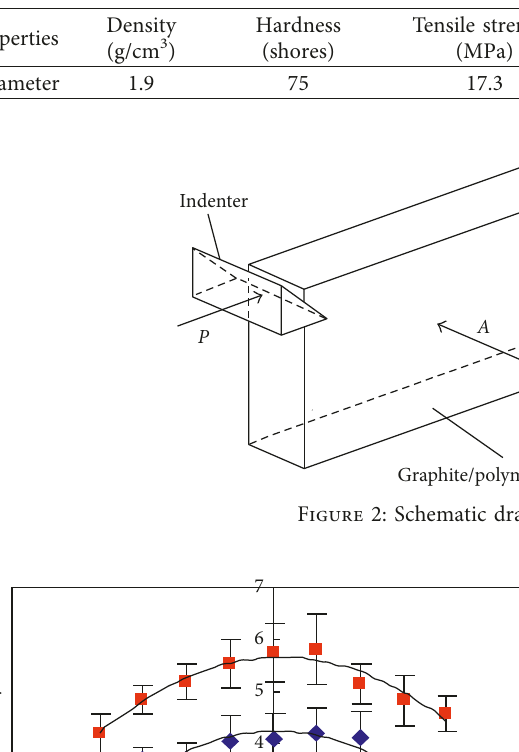
Table 1: Mechanical properties of graphite/polymer composites.